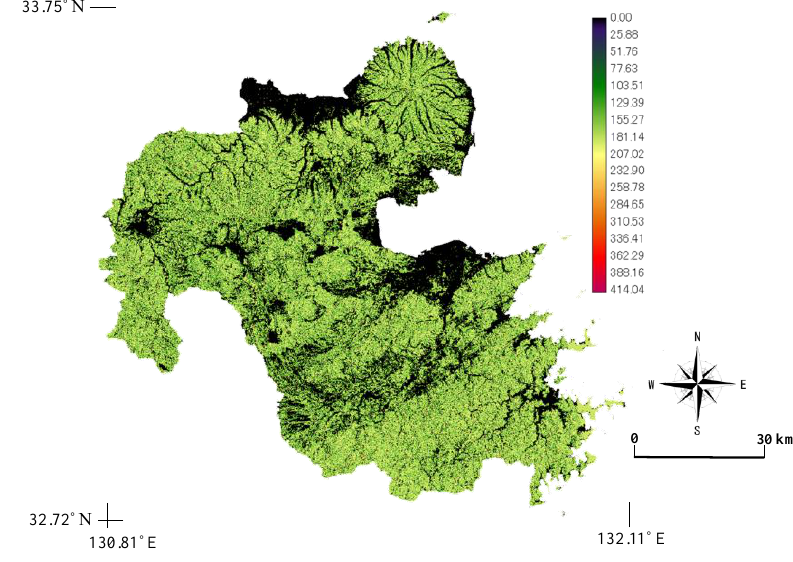
Figure 9. Stem volume map of the study area (m 3 /ha).